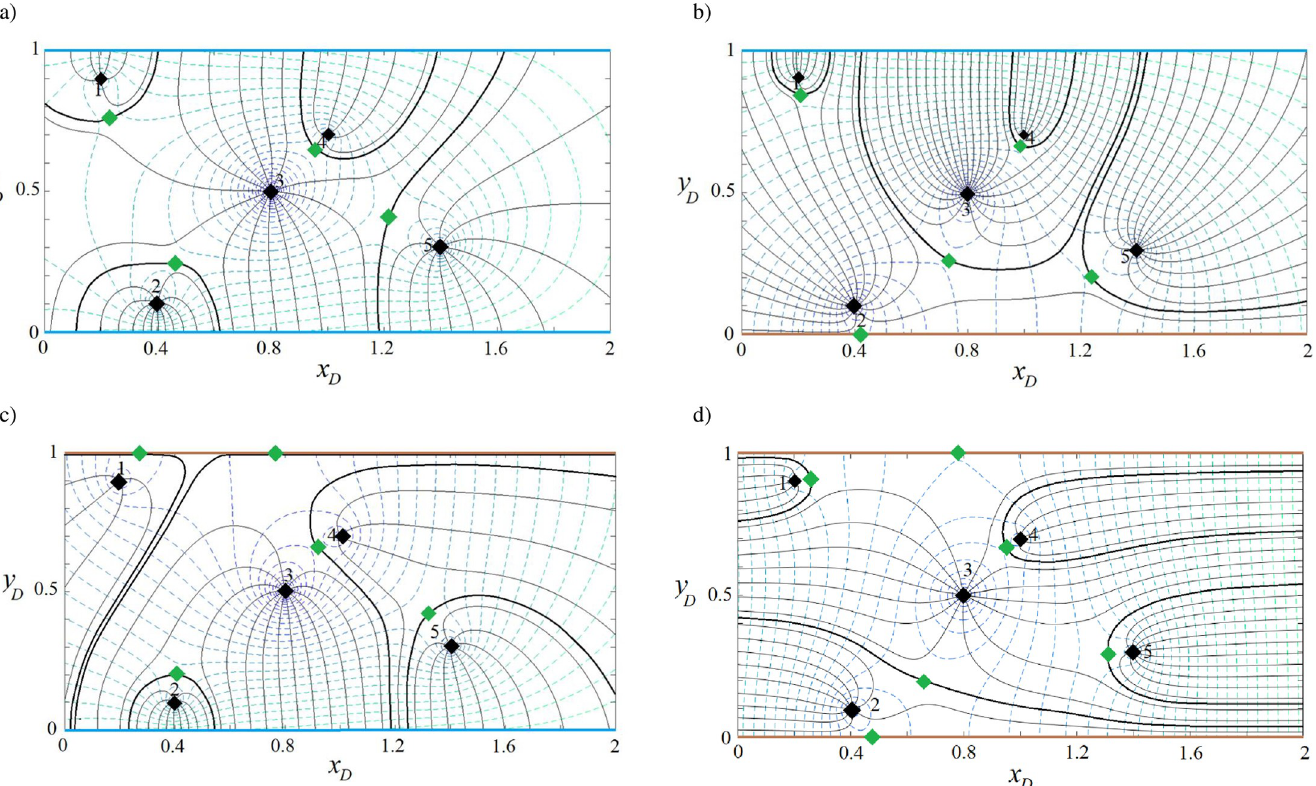
Fig 8. Velocity potential and streamlines when β = π in a strip-shaped aquifer with five extraction wells.